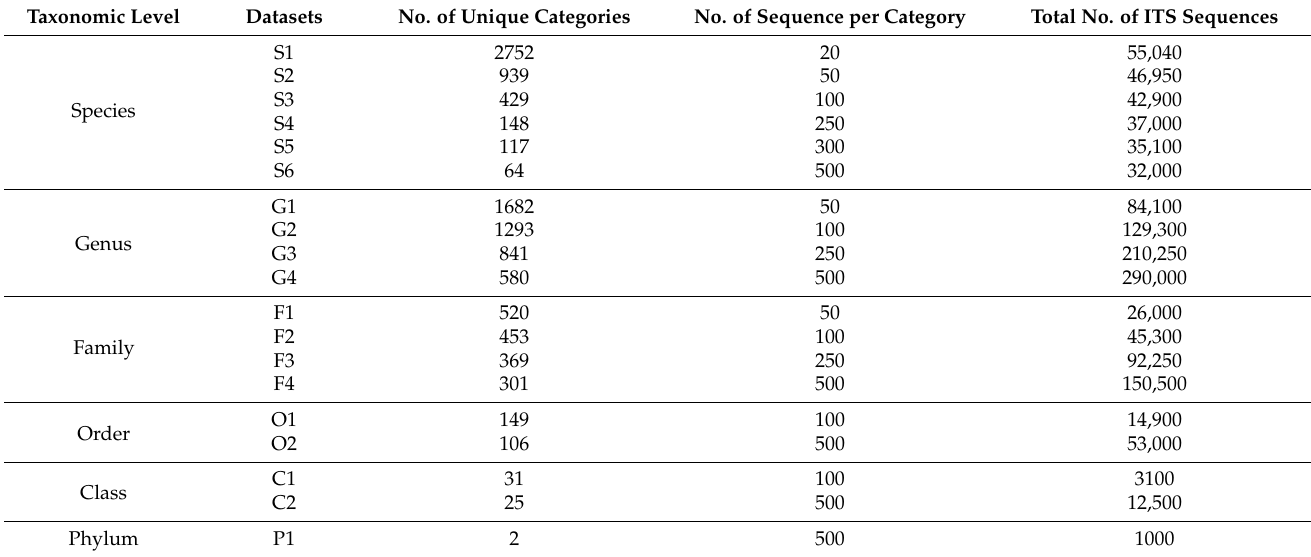
Table 2. Balanced datasets of ITS sequences with varying numbers of categories for all taxonomic levels.